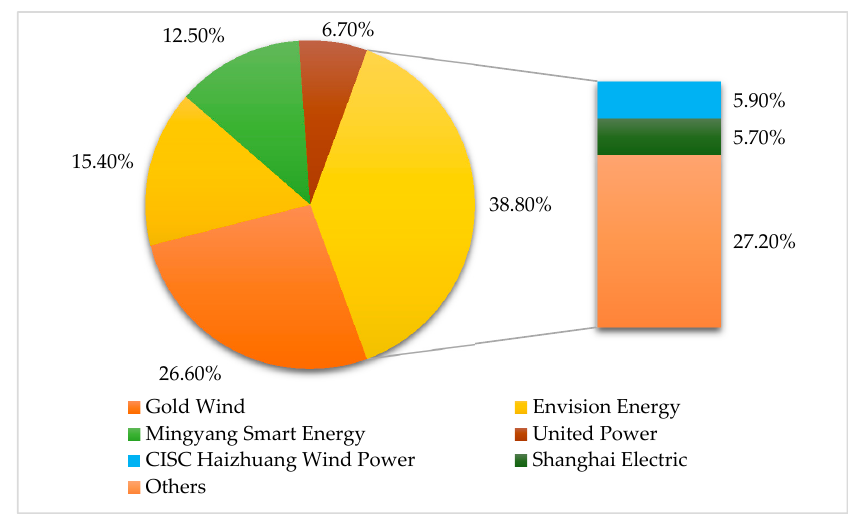
Figure 12. Wind turbine manufacturing of China in 2017 [71].